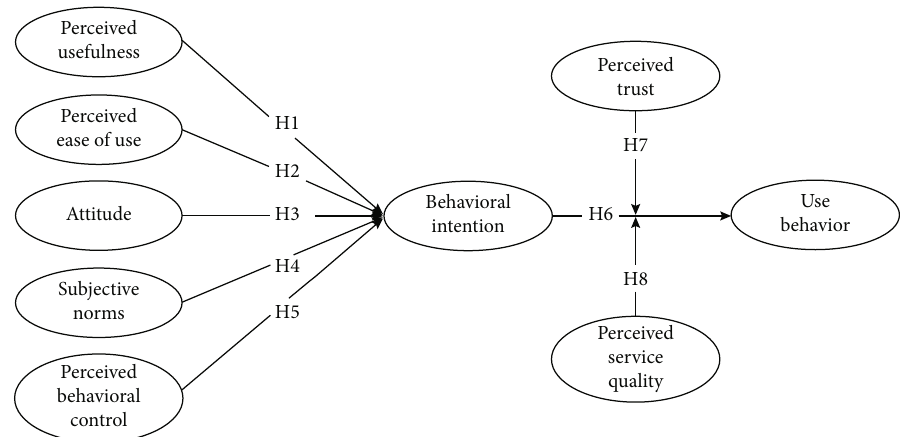
Figure 1: A proposed research